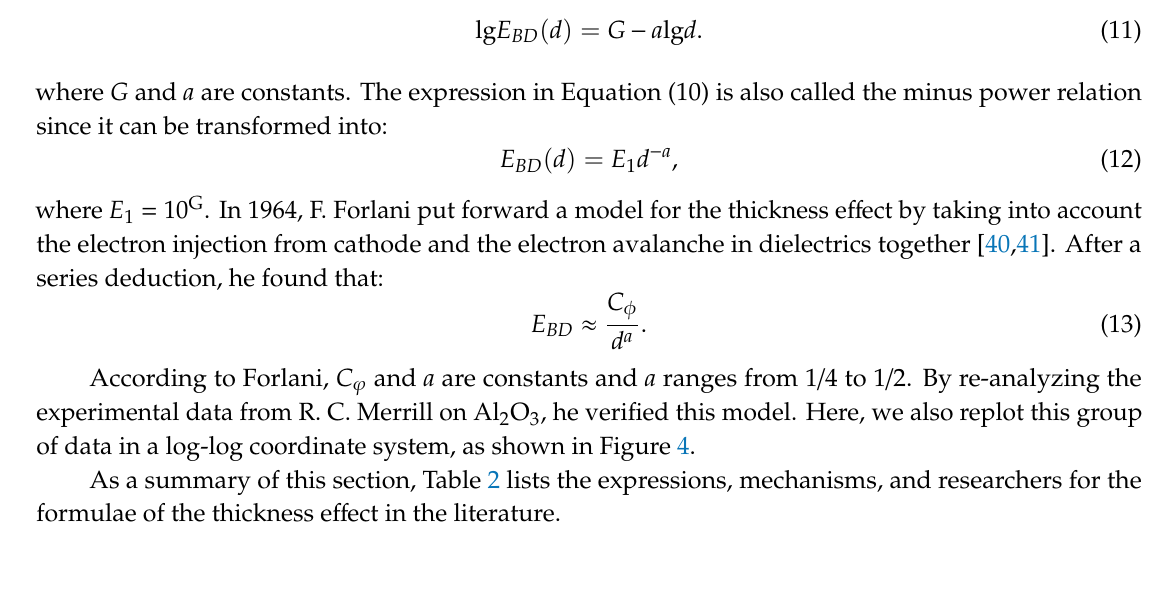
Figure 3. Experimental results to support the minus-single-logarithm relation of E